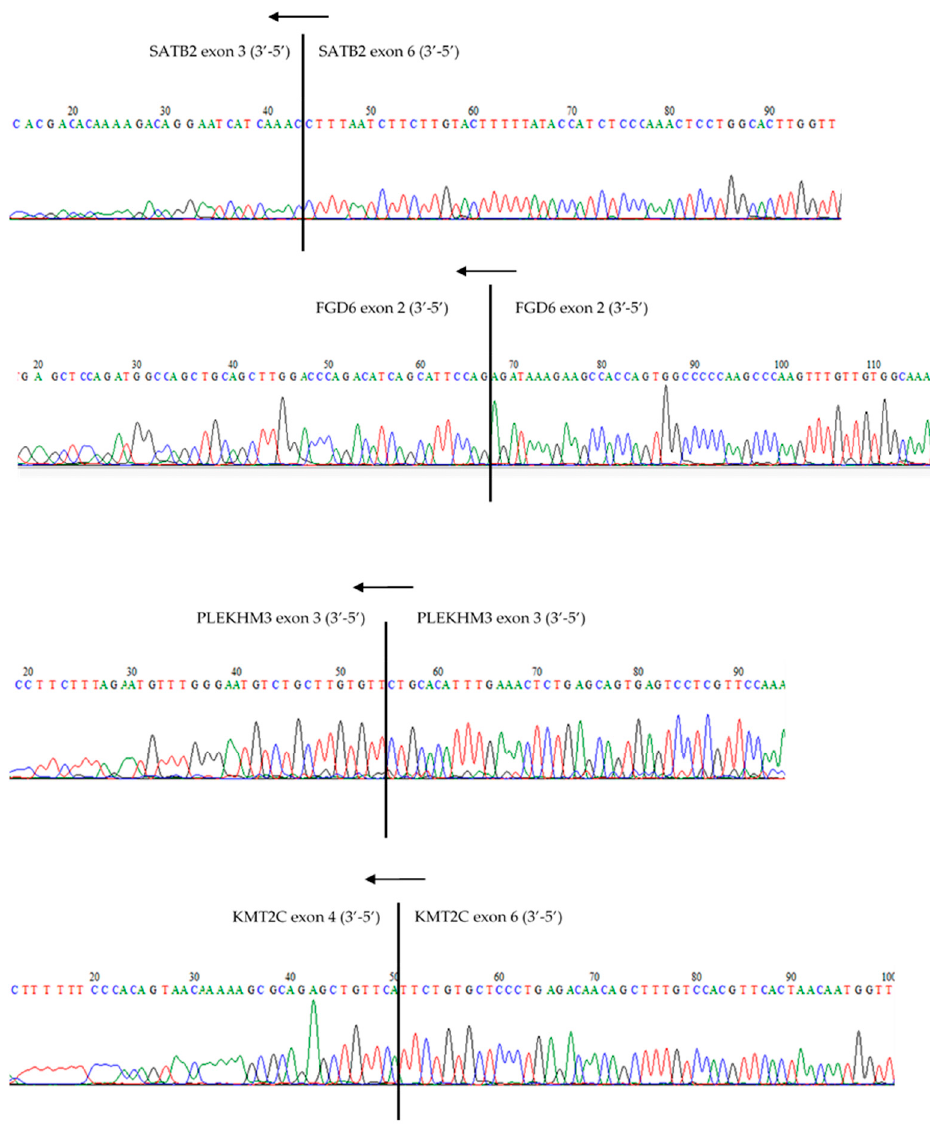
Figure 3. Sanger sequencing was used to validate the circular exon junctions of circSATB2, circKMT2C, circFGD6, and circPLEKHM3 identified from the RNAseq data.